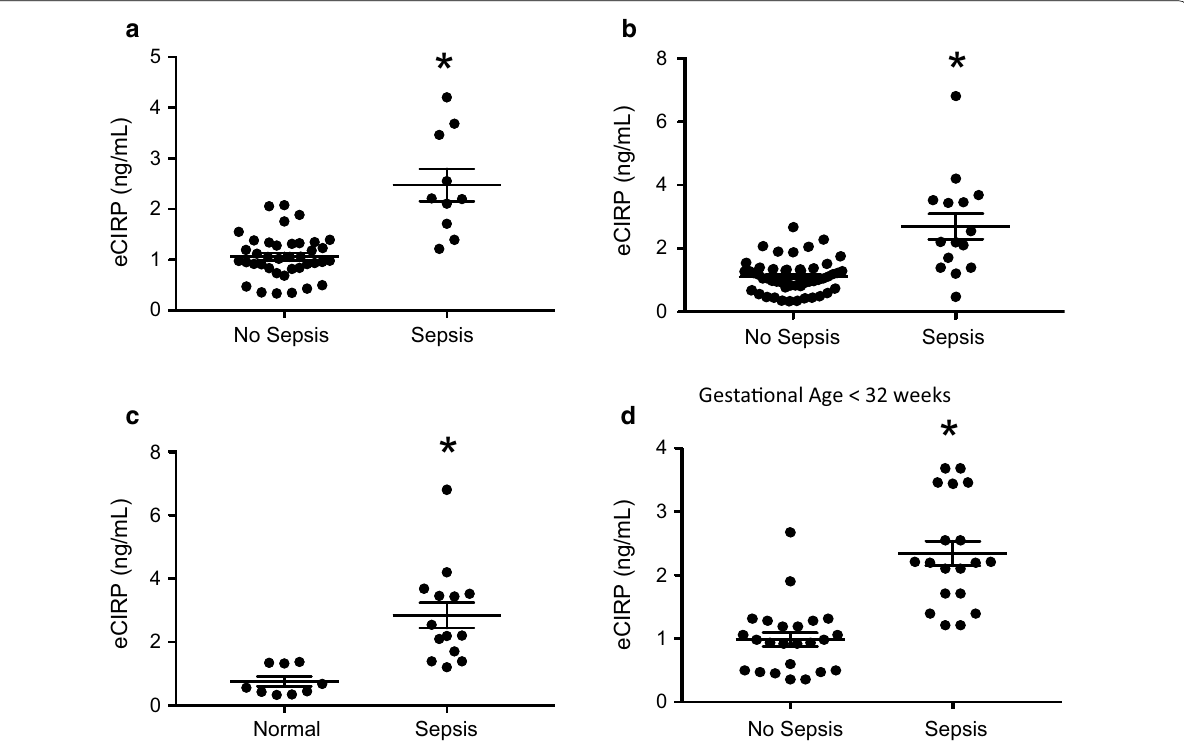
Fig. 1 Serum eCIRP levels are elevated in septic neonates. Serum levels of eCIRP were compared in a neonates classified as non‑septic (N versus septic (N 10) according to the electronic medical record. b Infants clinically classified as “sepsis rule‑out” were divided into the non‑septic = (N 52) vs septic (N 15) cohorts according to duration of antibiotics therapy. c Serum levels of eCIRP in full term, well infants (N = = compared to septic neonates (N 14). d Infants with a gestational age < 32 weeks of no sepsis (N = expressed as means SE and compared by two‑tailed student’s t test (* p < 0.05 vs no ±